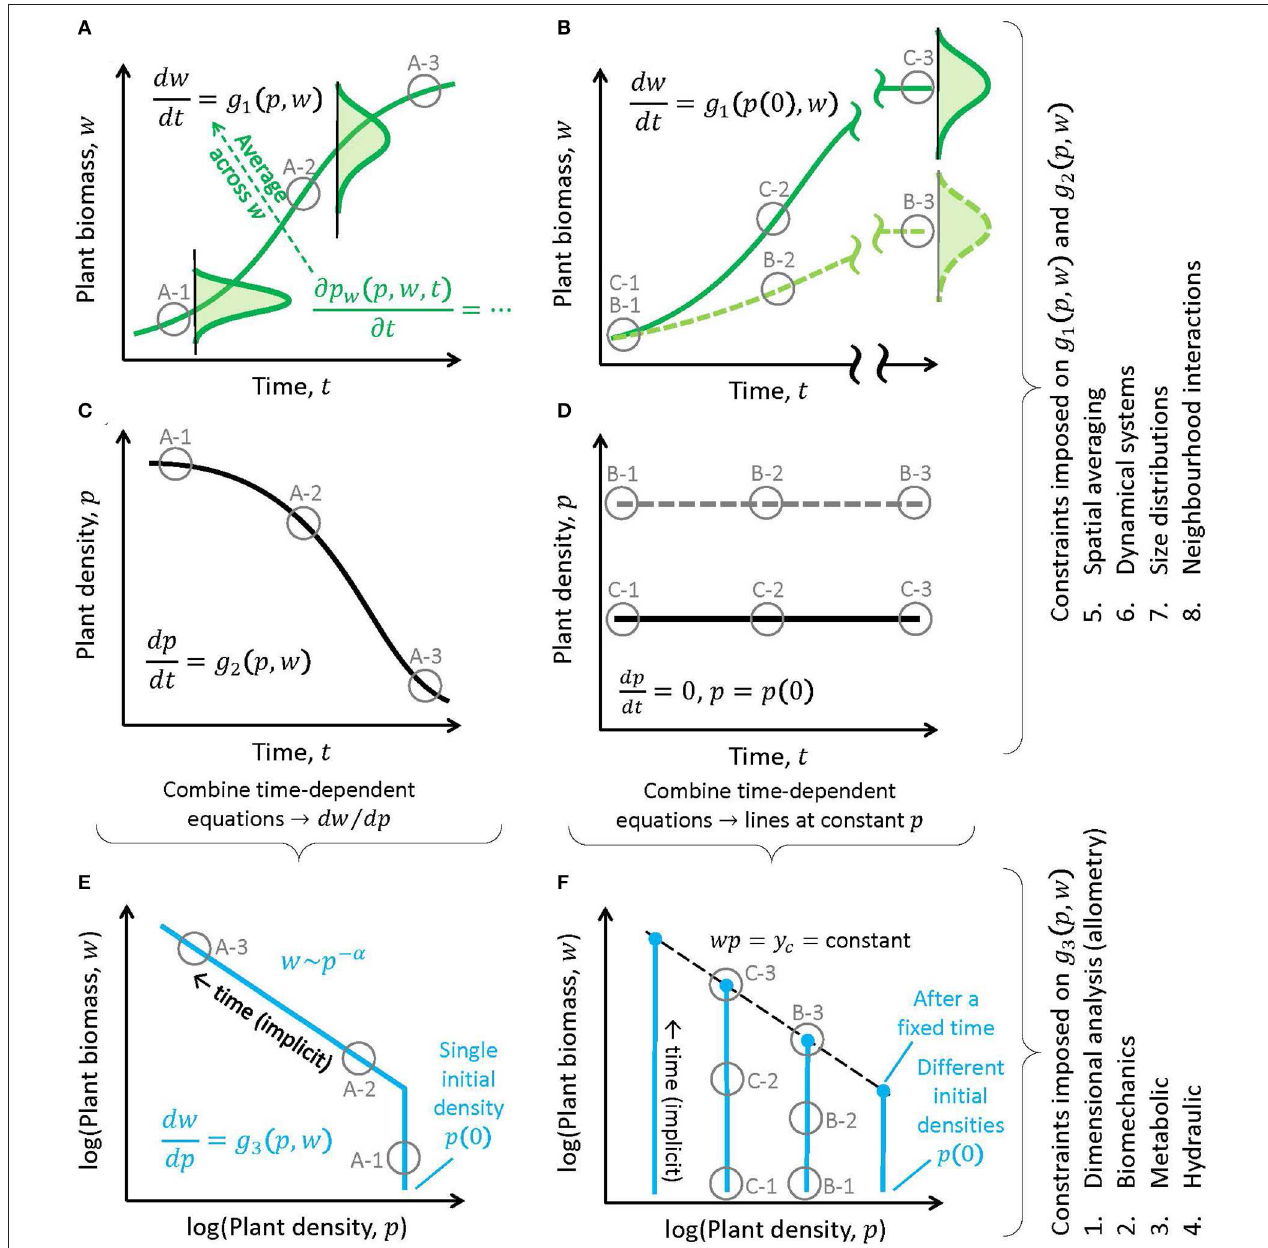
Cp − α ; left panels) and the FIGURE 2 | Linkages between dynamic equations for individual plant biomass ( w ) and density ( p ; Equation 5) for the self-thinning rule ( w = wp ; right panels). (A,B) Illustration of the time evolution of w (green curves: mean biomass; green curves with shaded area: probability constant final yield rule ( y c = densities of individual biomass in size-structured models). (C,D) Illustration of the time evolution of p . Combining the dynamic equations in subplots (A–C) and (B–D) , p phase space (Equation 6): (E) when starting from a single initial density, different experiments respectively, leads to a single equation describing trajectories in the w − and arguments show that α could vary from 1 to 3/2, or (F) multiple stands starting from different sowing densities achieve the same biomass per unit area y at a fixed point in time after sowing. Brackets right of the subplots: how constraints are imposed on the functions g 1(.) , g 2(.) , and g 3(.) of Equations (5) and (6); constraint numbering refers to the model categories discussed in the text (see also Figure 3). Gray circles and labels correspond to the scenarios depicted in Figure 1 .